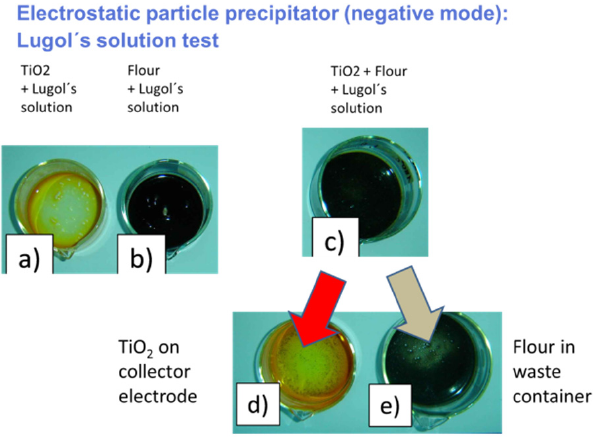
Figure 22. Lugol’s test applied to pure TiO 2 ( a ) and to pure flour ( b ) demonstrating the presence of starch in ( b ); ( c ) Lugol’s test applied to a mixture of flour and TiO 2 ; after passing this mix through the ESP separator, the mix is separated into almost pure fractions of TiO 2 ( d ) and flour ( e ).